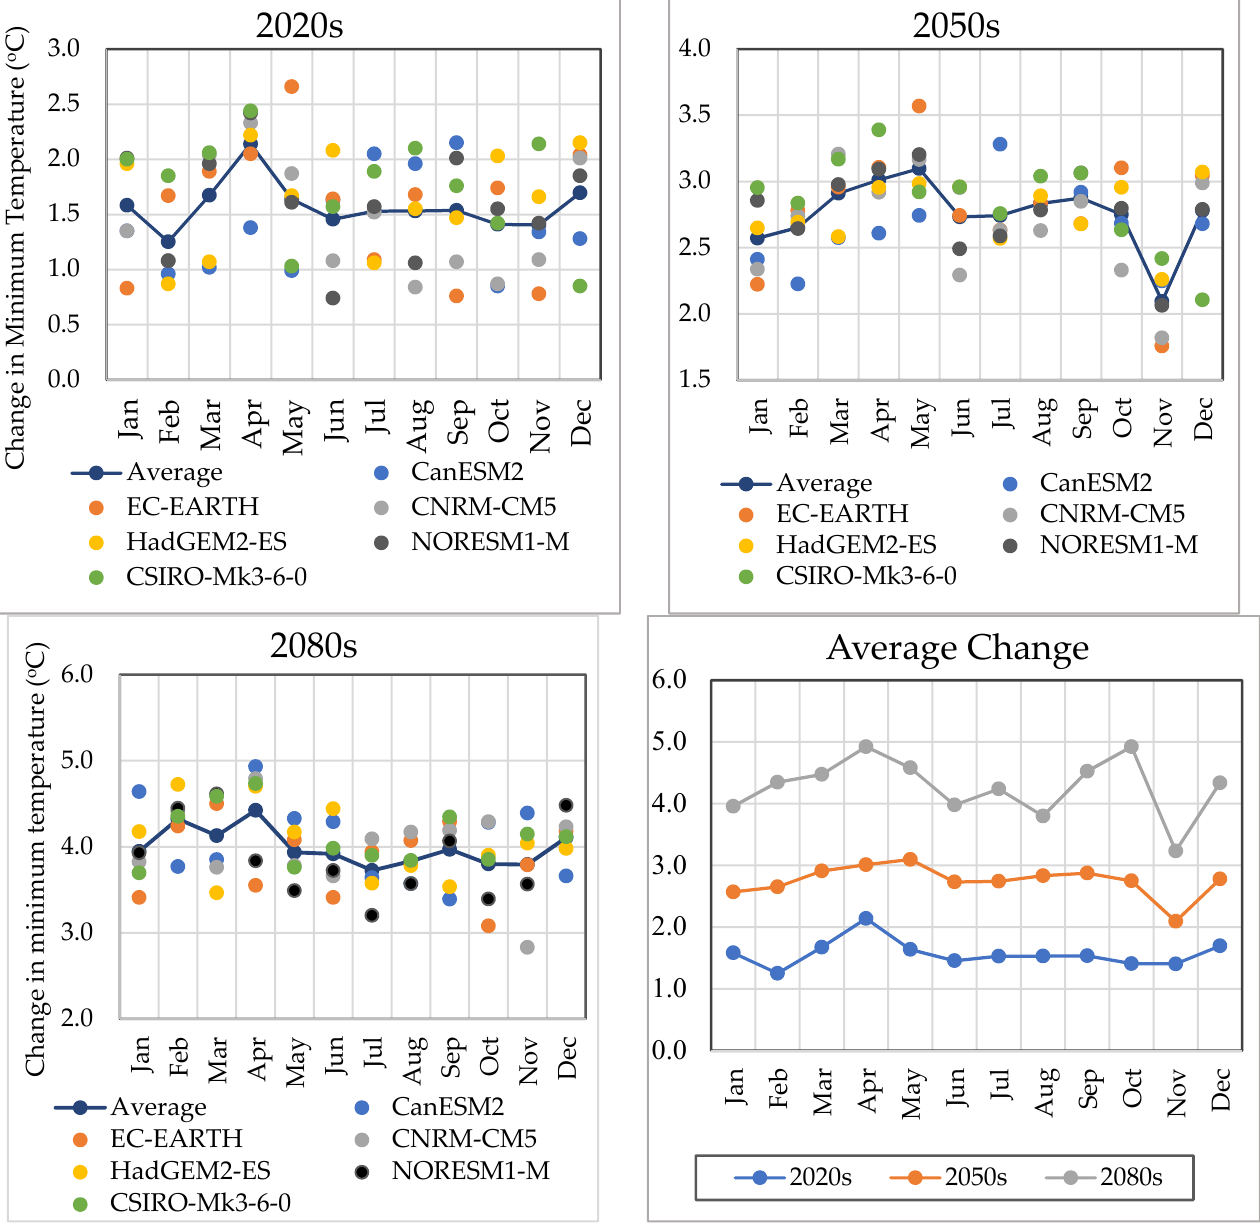
Figure 3. Change in minimum temperature in 2020s, 2050s, and 2080s, including the average change in all climate models.